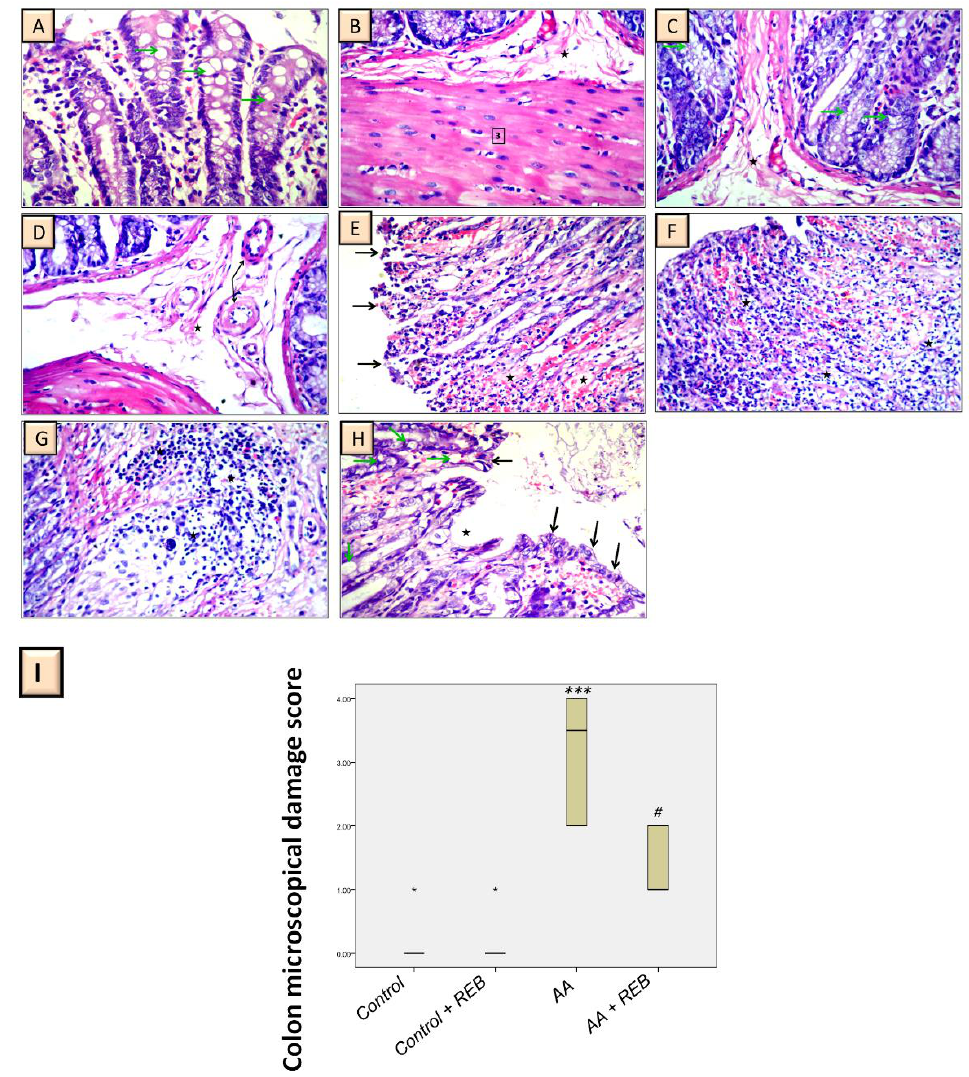
Figure 3. Rebamipide administration attenuates the colonic histopathological aberrations induced by acetic acid (H–E stain; 400 × higher magnification). The photomicrographs at higher magnification demonstrated that the control group shows intact goblet cells and intestinal glands (green arrow) ( A ) and a normal picture of the submucosa (star) ( B ). Similar findings for the rebamipide-treated group were also observed as shown by the normal appearance of the submucosa (star) and intestinal gland (green arrow) ( C ) with a normal picture of the submucosa (star) and its blood vessels (arrow) ( D ). On the contrary, the colitis group shows a severe loss of the epithelium (arrow), hemorrhage intermingled with inflammatory cellular infiltration in the mucosa (star) ( E ), severe mixed inflam- matory cellular infiltration (star) extending up to the submucosa ( F ), mixed inflammatory cellular infiltration, and micro-abscess formation in the submucosa (star) ( G ). Alternatively, rebamipide ad- ministration markedly protected the colon against colitis as indicated by the intact lamina epithelial cells (arrow), and few ulcers (star) ( H ). ( I ) The injury in the colonic sections was quantified as the colon microscopical damage scores. The scores were expressed as the median with the interquartile range ( n = 6). The Kruskal–Wallis test was conducted to analyze the significant difference among tested groups followed by the Dunn’s test. *** p < 0.001, significant from the control group. # p < 0.05, significant from the colonic injury group. REB, rebamipide; AA, acetic acid.